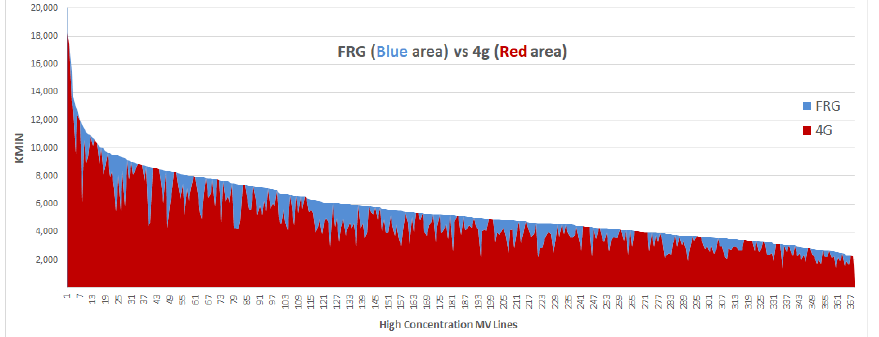
1 analysis. The blue area represents the gain of Figure 15. High concentration MV lines N − performances adopting the 4G procedure for DAS. The lines are ordered from the line with the highest mean impact to the